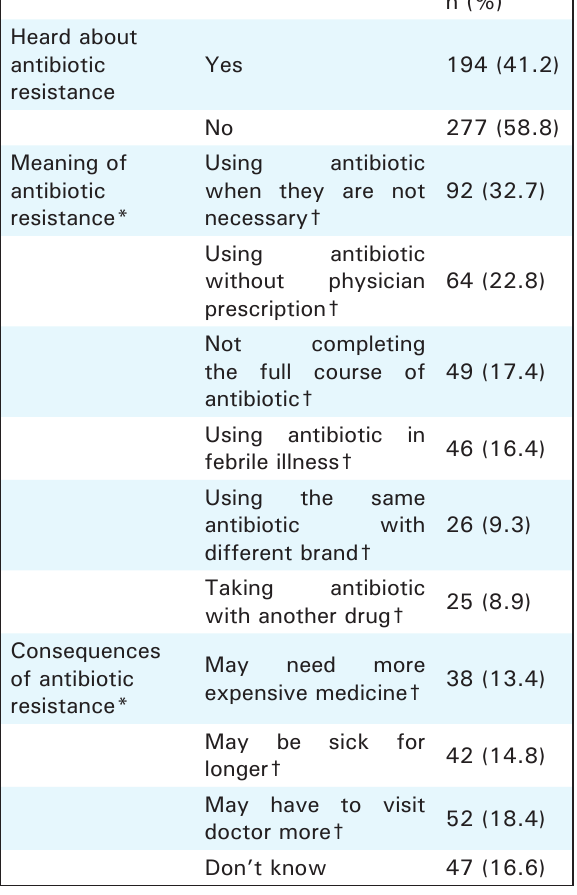
Table 3. Knowledge regarding antibiotic resistance.